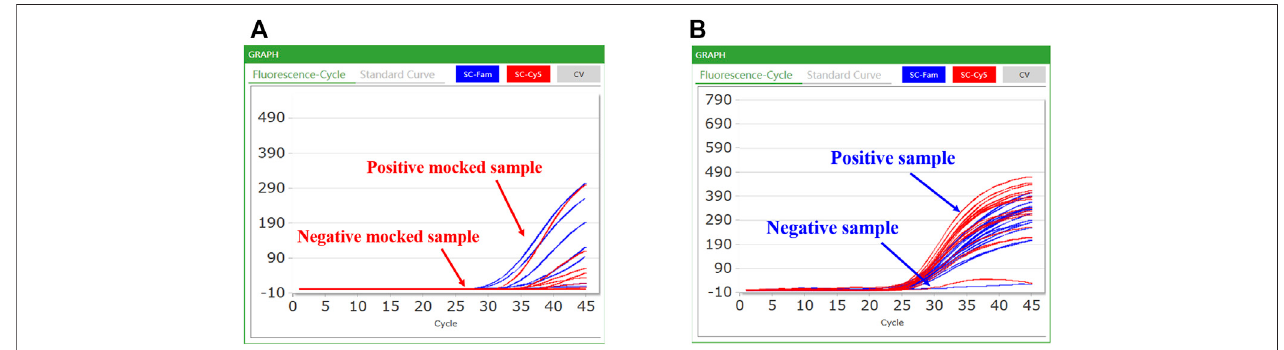
FIGURE 5 | Representative results of the CQ100 assay performed in samples: (A) the mocked COVID-19 samples; (B) the clinical C. dif fi cile samples. A positive samplehadanS-shapedcurvebasedontheFAMandCy5channeldetectionandtheCtvalueof ≤ 38;incontrast,anegativesamplehadadifferentlyshapedcurveinthe FAM and Cy5 channels.